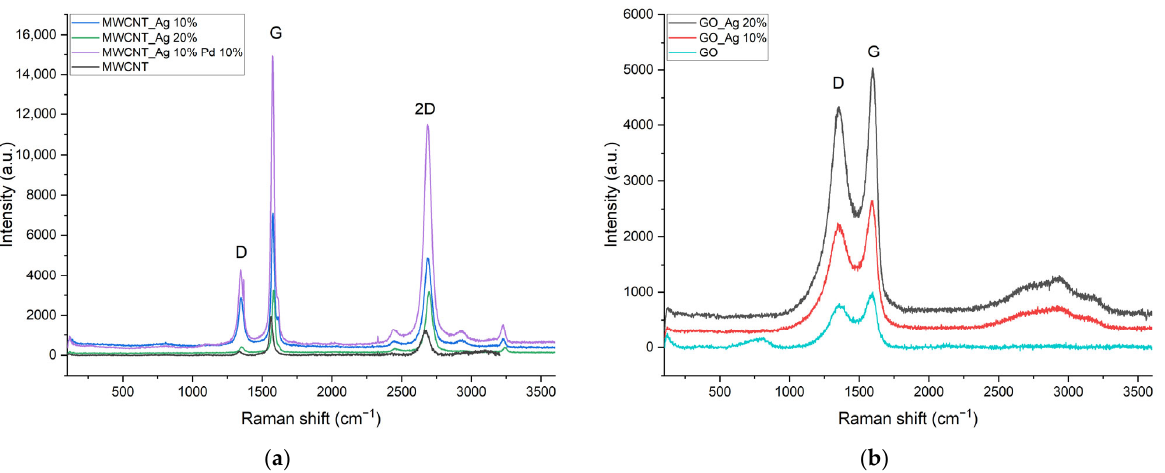
Figure 2. Raman spectra of synthesized samples and initial carbon supports: ( a ) MWCNT materials, ( b ) GO materials.